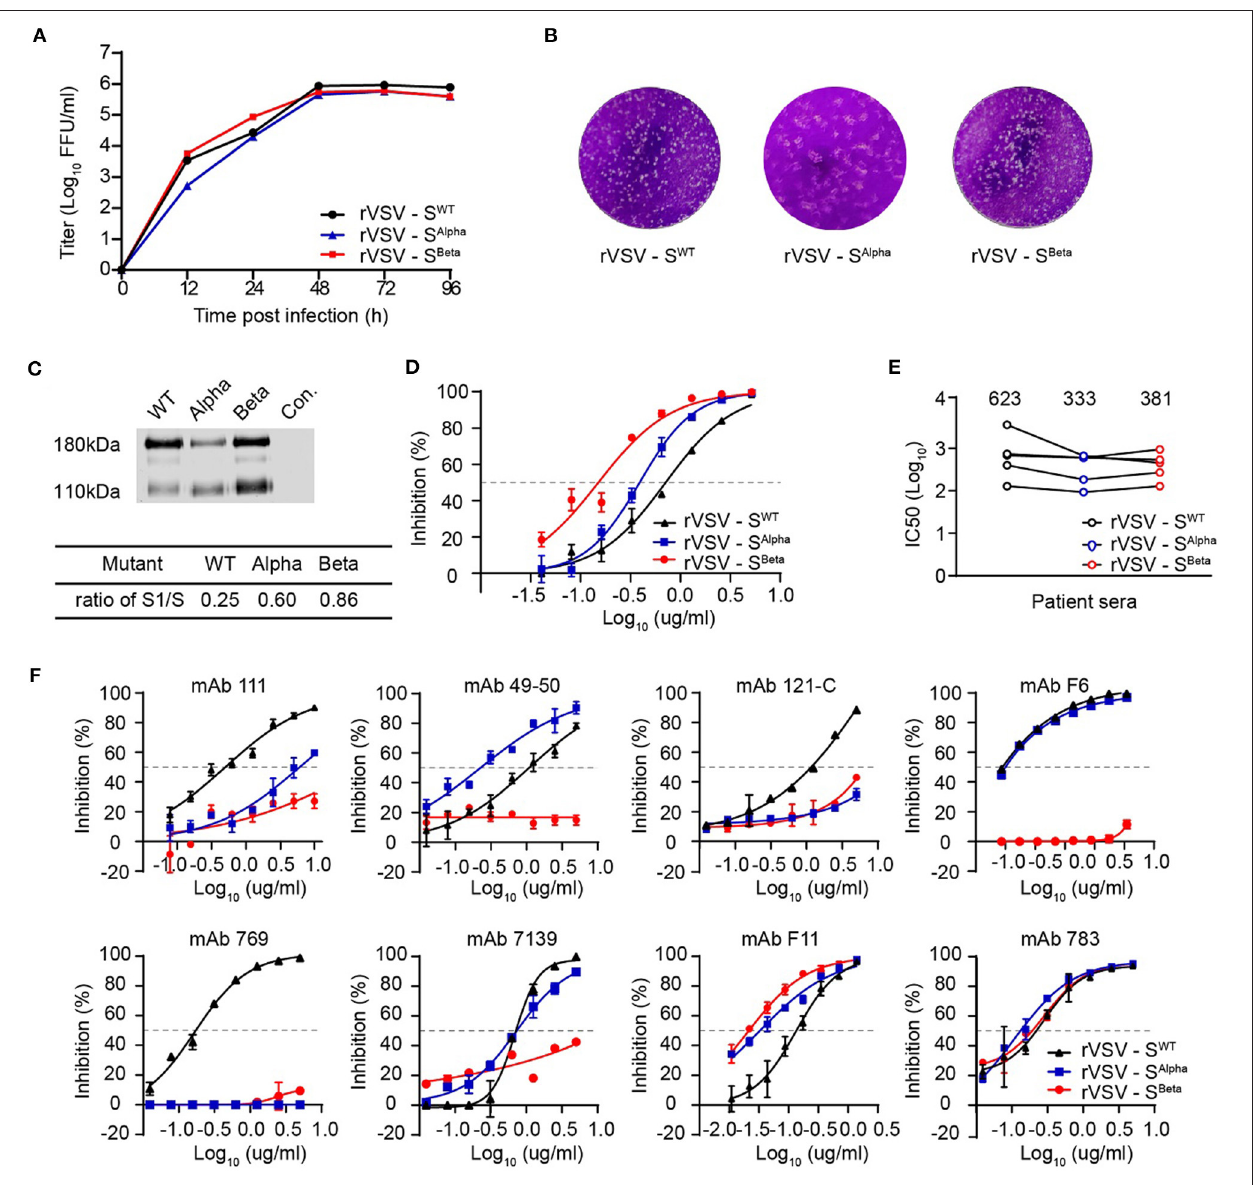
FIGURE 5 | Characterizations of recently emerged variants of concern, Alpha and Beta. (A,B) The growth kinetics and plaque morphology of rVSV-S Alpha and Beta variants determined in Vero cells as above. The result is representative of three independent experiments. (C) Purified rVSVs were analyzed by western blot using a polyclonal antibody recognizing the RBD domain of the S protein. The result is representative of three independent experiments. The S1/S ratio was quantified by scanning gray values in Image Studio Ver 5.2 Software (LICOR Biosciences, USA) and calculated significant differences by GraphPad Prism 9.0. (D) The inhibitory activity of soluble ACE2 against rVSV-S WT , Alpha, and Beta variants. (E) Neutralization activity of sera from COVID-19 convalescence patients against rVSV-S variants. Using the FRNT, five sera samples were tested against rVSV-S WT , Alpha, and Beta variants. (F) Neutralization activity of mAbs against rVSV-S variants. The FRNT tested eight mAbs against rVSV-S WT , Alpha, and Beta variants. Error bars represent SD. All neutralization assays were performed in